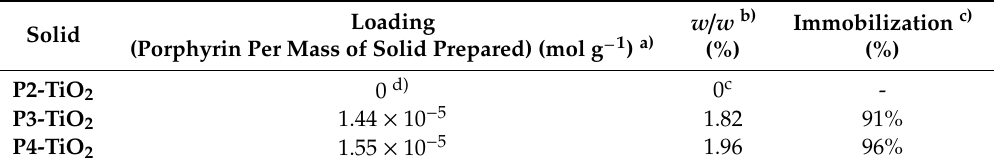
Table 3. Porphyrin immobilization on titanium dioxide solid